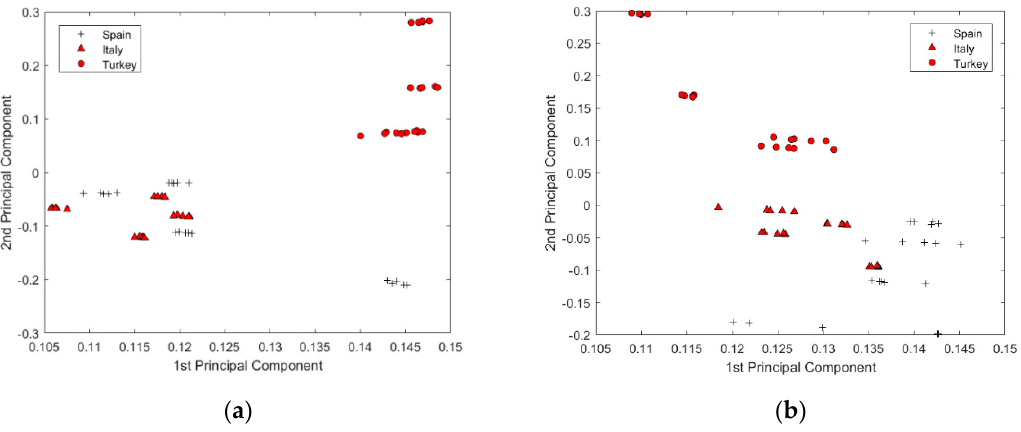
Figure 5. Scores plot of ( a ) untransformed raw data, ( b ) multiplicative scatter correction followed by the first-level derivative (MSC-Der1) pretreated data.